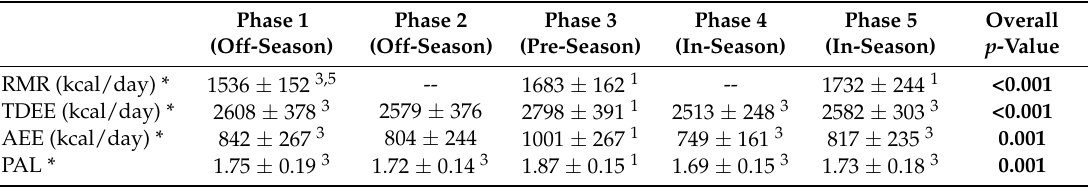
Table 2. Resting Metabolism and Daily Energy Expenditure over the Academic